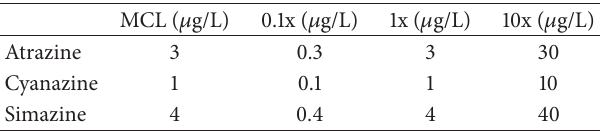
Table 1: Pesticide use levels based upon US EPA maximum contamination levels (MCL) for drinking water. Modified from Rich et al.